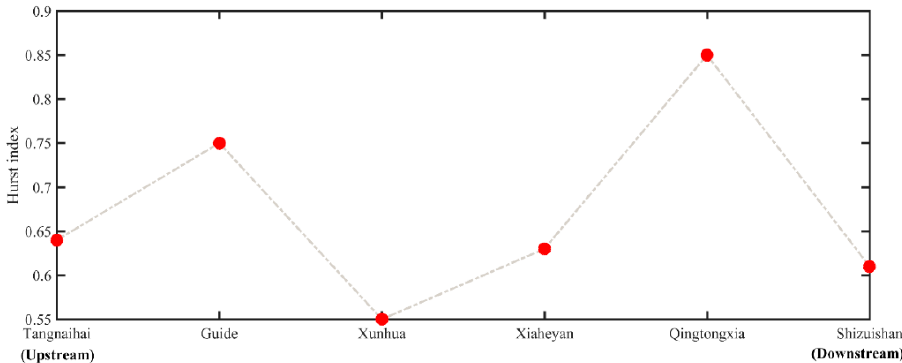
Figure 8. Hurst index for the baseflow trend forecast at the six hydrological stations.